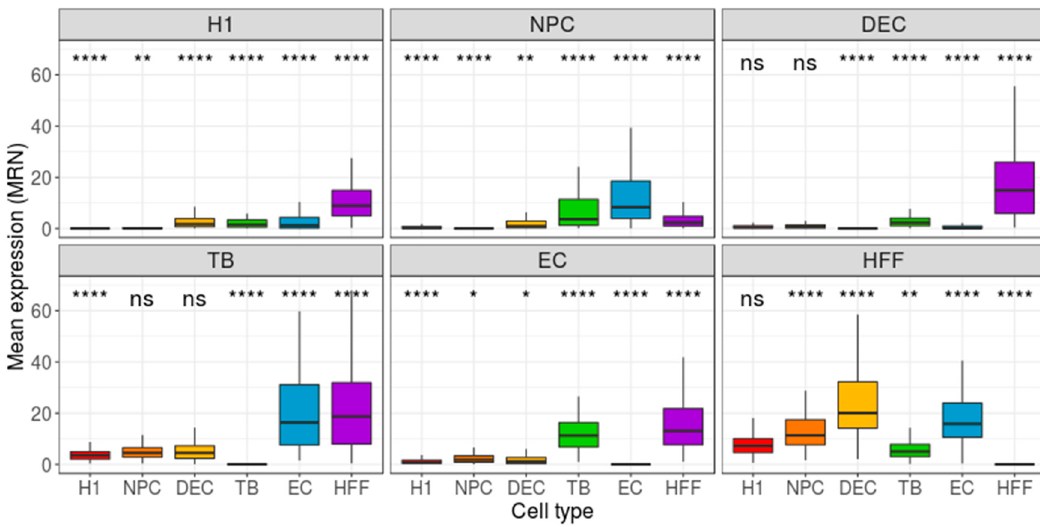
highest gene-centered MAE scores within the H1 group). H1: human embryonic stem cells ( n = 375 cells); NPC: neural progenitor cells ( n = 173 cells); DEP: definitive endoderm progenitors ( n = 138 cells); EC: endothelial cells ( n = 105 cells); TB: trophoblasts ( n = 69 cells); HFF: human foreskin fibroblasts ( n = 159 cells). Each group was compared to all other cell types, combined, using a